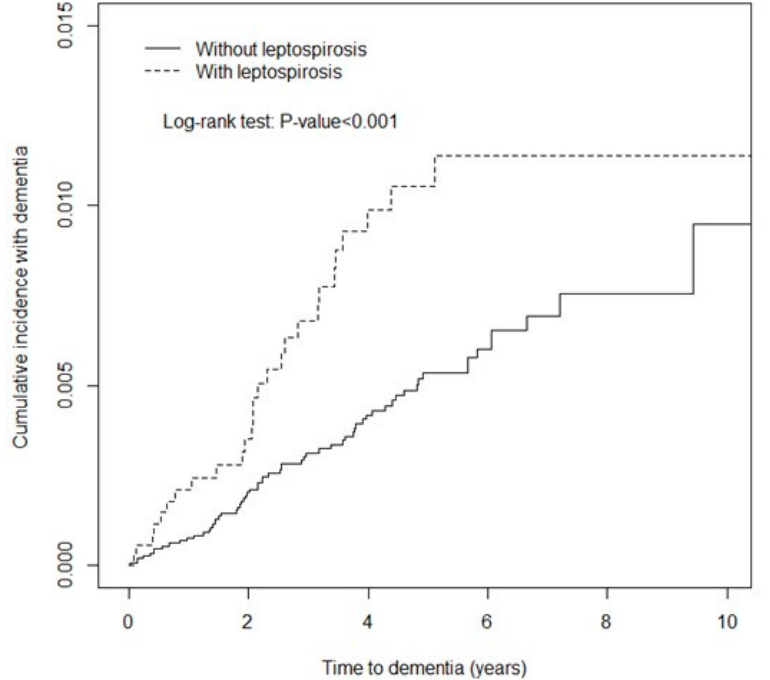
Figure 1. Comparison of the cumulative incidence of dementia in the leptospirosis cohort and non-leptospirosis c.